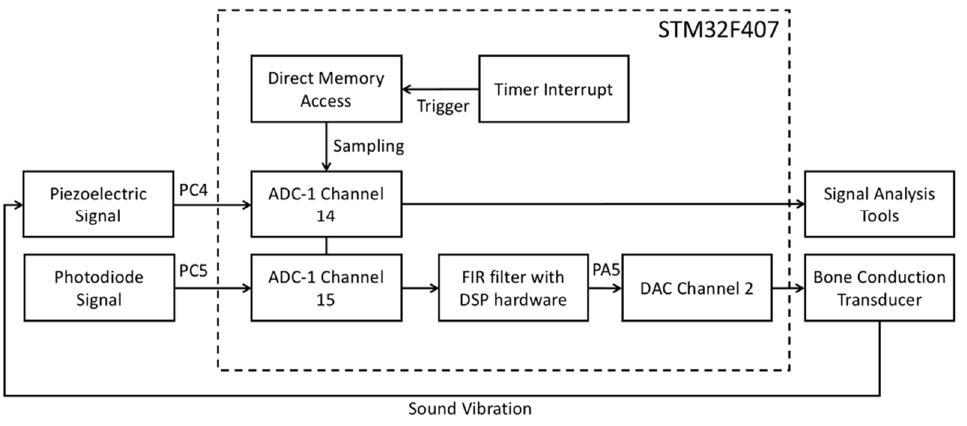
Figure 15. Digital signal processing flowchart.